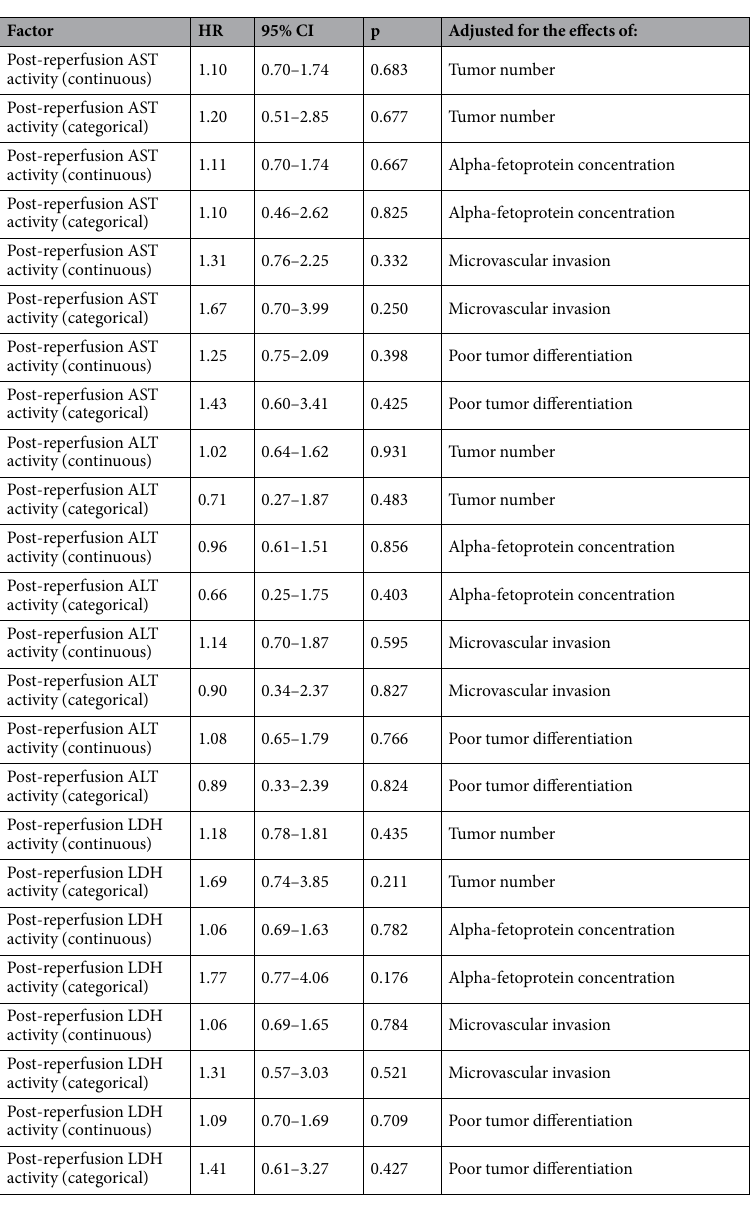
Table 4. Analyses of the effects of the degree of ischemia-reperfusion injury on the risk of hepatocellular carcinoma recurrence after liver transplantation adjusted for the confounding influence of independent risk factors. HR – hazard ratio; 95% CI – 95% confidence interval; AST – aspartate transaminase; ALT – alanine transaminase; LDH – lactate